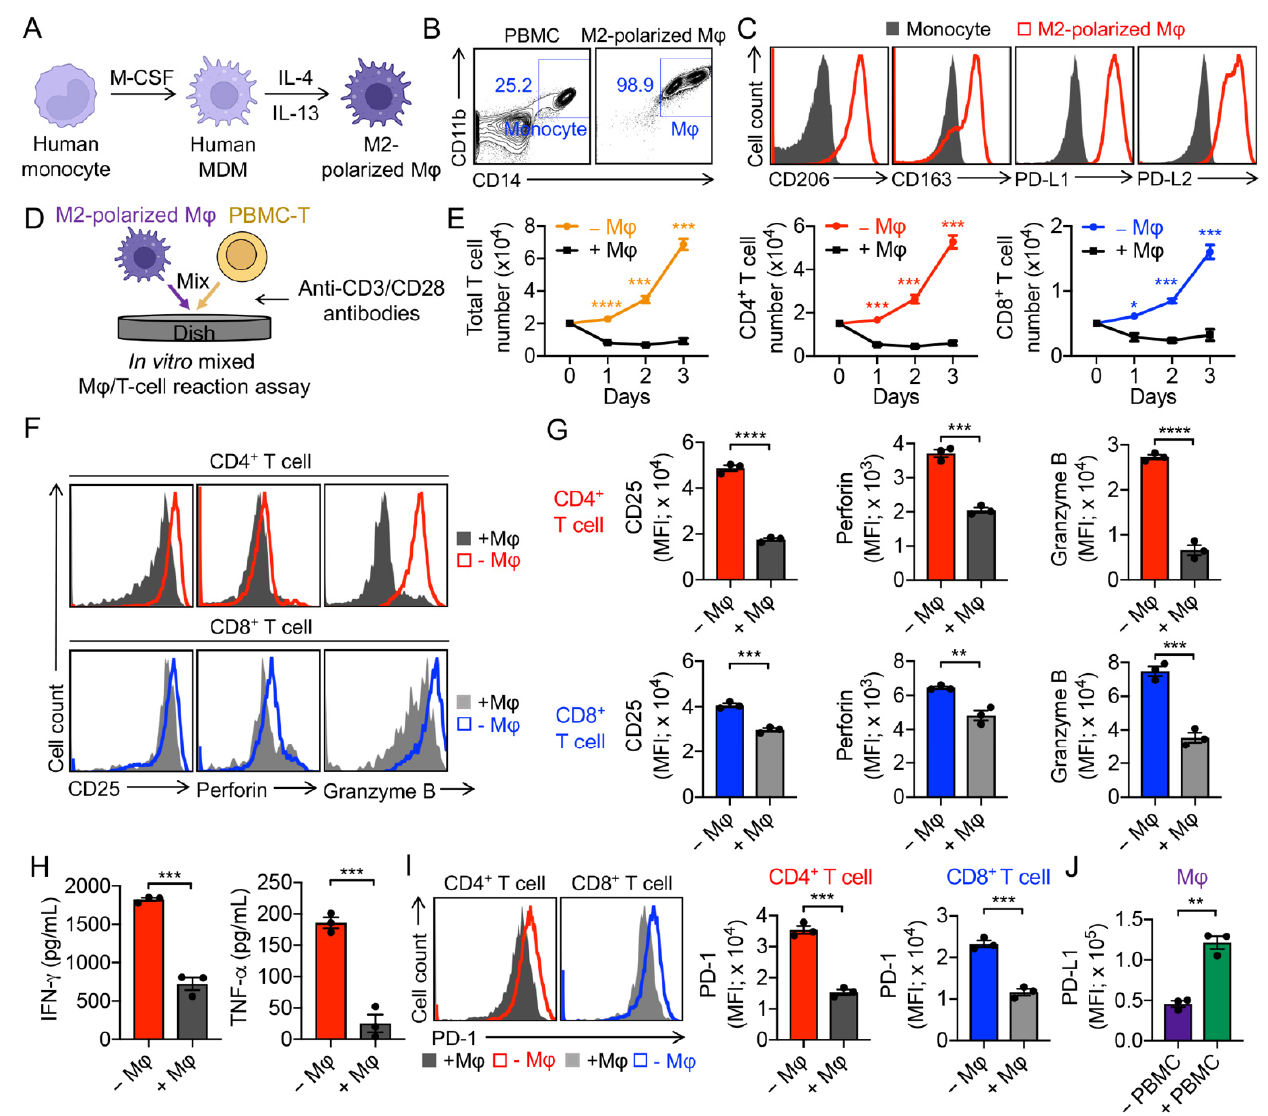
Figure 1. Generation and validation of human monocyte-derived M2-polarized immunosuppressive macrophages. ( A ) Diagram showing the human monocyte-derived M2 macrophage culture and polarization. M-CSF, macrophage colony-stimulating factor; MDM, monocyte-derived macrophage; M ϕ , macrophage. ( B ) Fluorescence-activated cell sorting (FACS) detection of CD11b and CD14 on M2-polarized macrophages. Healthy donor peripheral blood mononuclear cells (PBMCs) were included as a staining control. ( C ) FACS detection of surface markers on M2-polarized macrophages. Monocytes were included as a control. ( D – J ) In vitro mixed M ϕ /T-cell reaction assay to study M2 macrophage-mediated T-cell suppression. ( D ) Experimental design. 1 × 10 5 PBMCs were cultured in the assay. ( E ) PBMC-T-cell growth curve ( n = 3). ( F ) FACS detection of surface marker (CD25) and intracellular cytotoxic molecules (Perforin and Granzyme B) of CD4 + and CD8 + T cells. (G) Quantification of F ( n = 3). ( H ) ELISA analyses of cytokine (IFN- γ and TNF- α ) production in the mixed reaction assay at day 3 ( n = 3). (I) FACS analyses of PD-1 on CD4 + and CD8 + T cells ( n = 3). ( J ) FACS analyses of PD-L1 on M2 macrophages ( n = 3). Representative of 3 ( D – J ) and > 5 ( A – C ) experiments. Data are presented as the mean ± SEM. * p < 0.05, * * p < 0.01, ** * p < 0.001, *** * p < 0.0001, by Student’s t test.